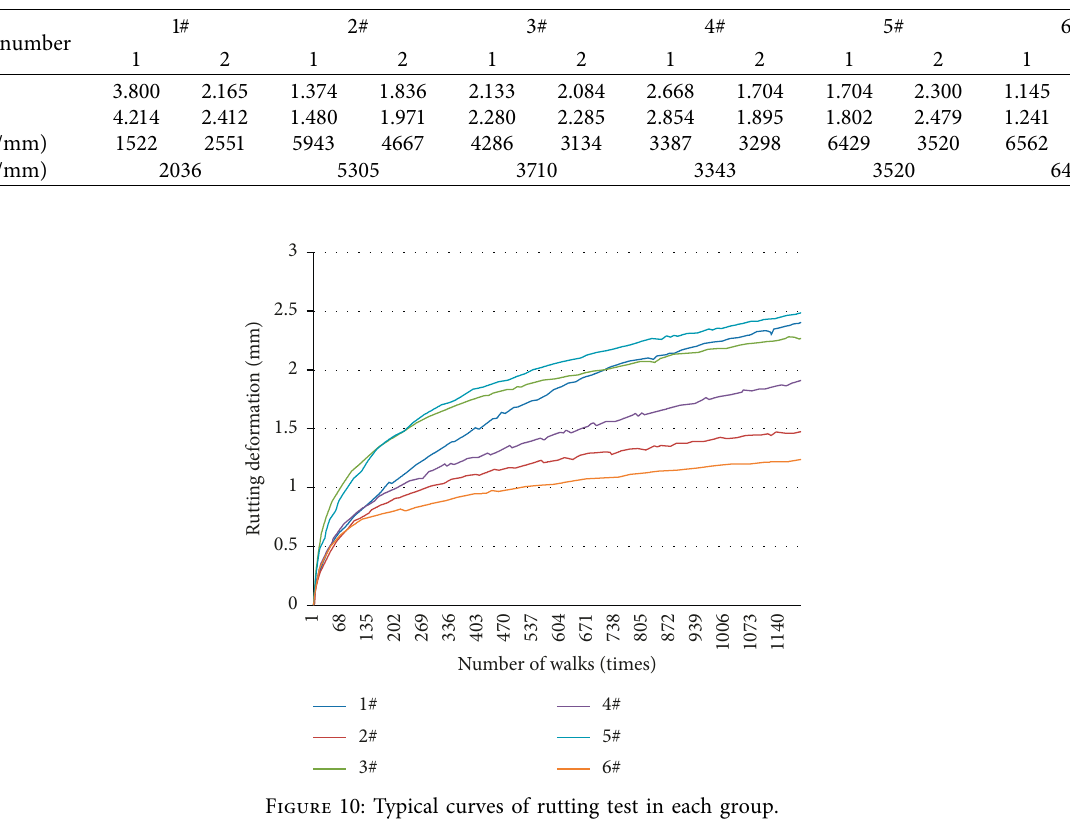
Table 7: Results of rutting test of mixture.